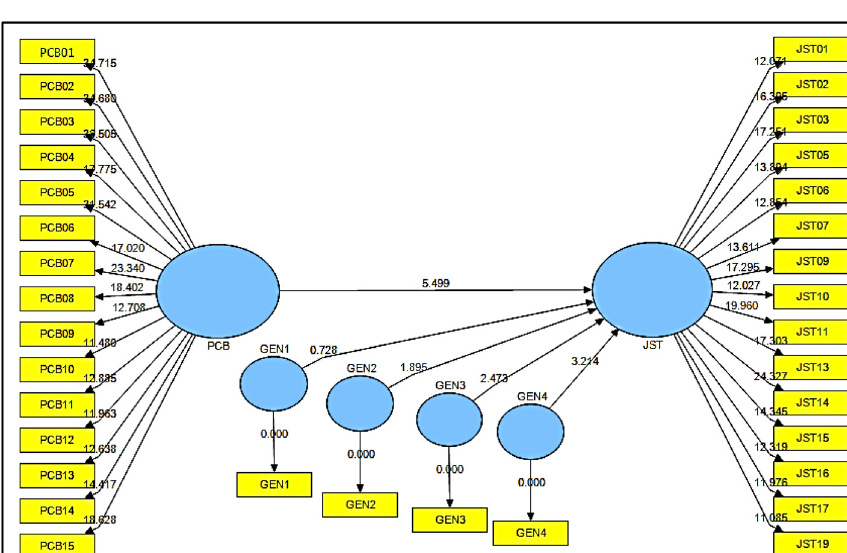
Figure 2. Coef fi cient of path linking PCB to JST